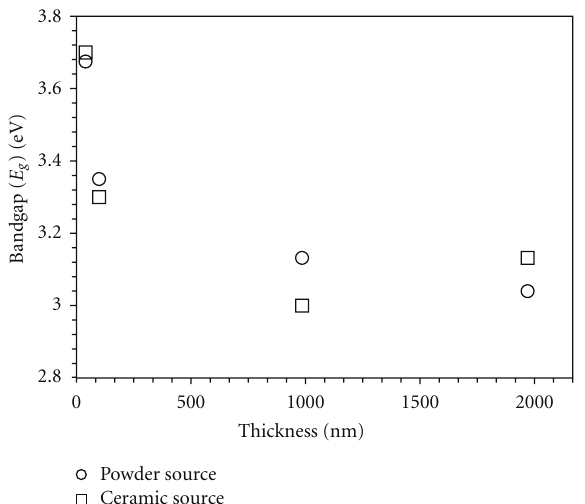
Figure 12: Variation of E g with thickness for both growth